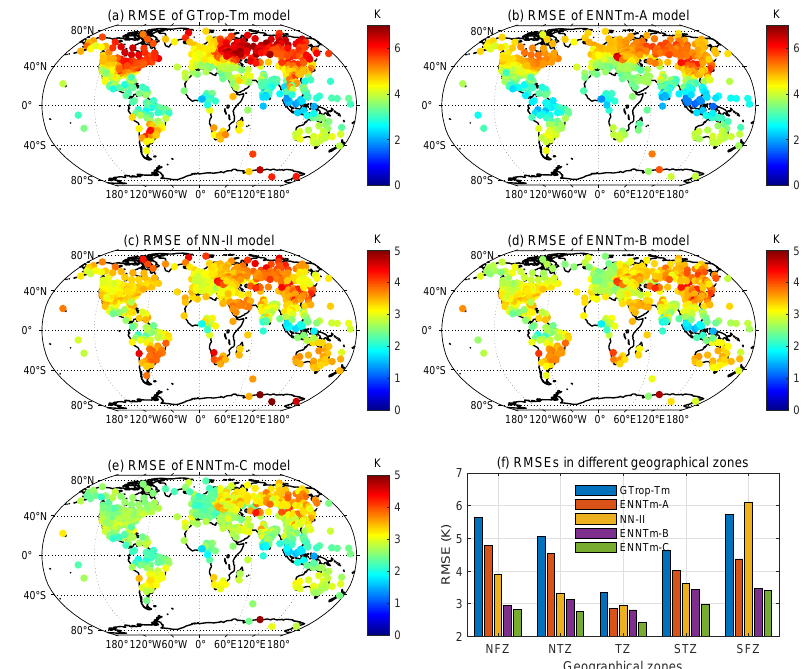
Figure 9. The scattergram of RMSE (root-mean-square error) for ( a ) GTrop-Tm model, ( b ) ENNTm-A model, ( c ) NN-II model, ( d ) ENNTm-B model and ( e ) ENNTm-C model at each test IGRA station, and ( f ) their statistics in different geographical zones validated by radiosonde data during 2017 and